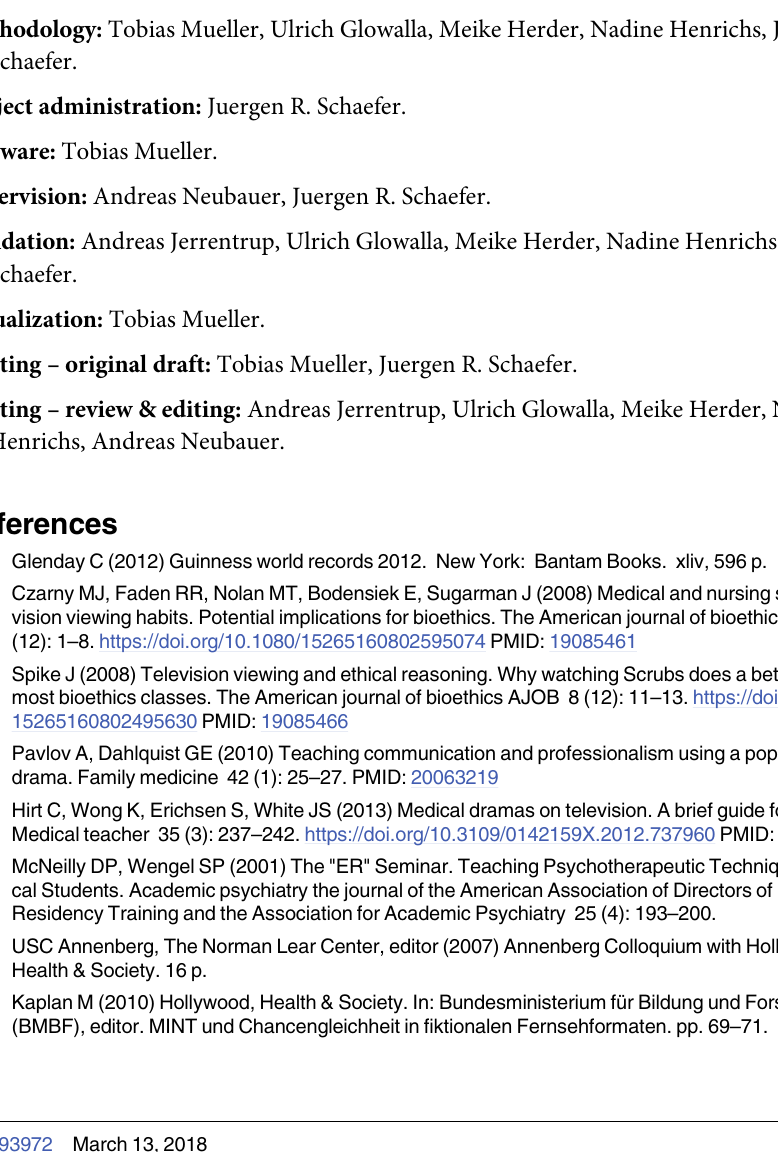
S1 Table. This is the dataset obtained from the participants with English headers. S2 Table. This is the original dataset obtained from the participants with German